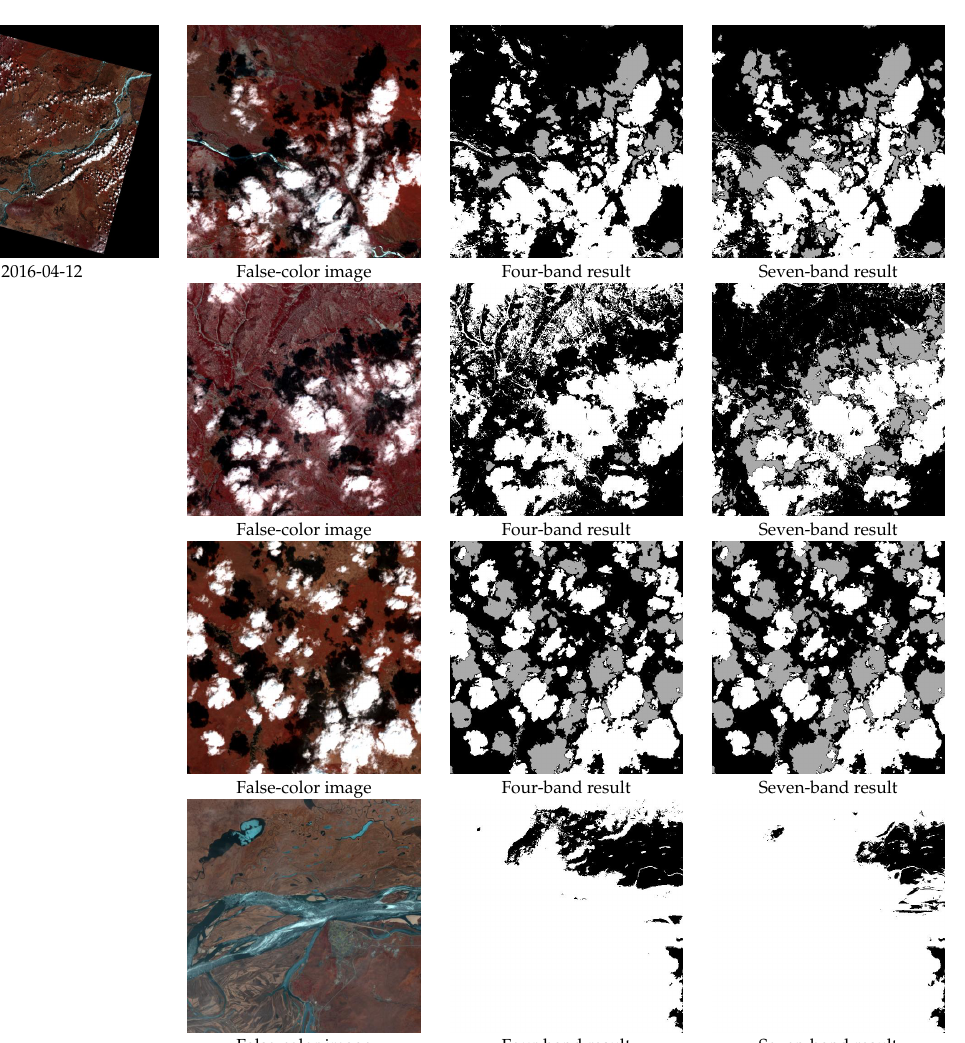
Figure 16. Segmentation results of four-band and seven-band models in some local areas (L8, Path 113, Row 26). From left to right are false-color images, results of the four-band model, and results of the seven-band model. Bands 5 NIR, 4 Red, and 3 Green are combined together as RGB channels to construct a false-color image for visualization. Some differences between shadow detections are